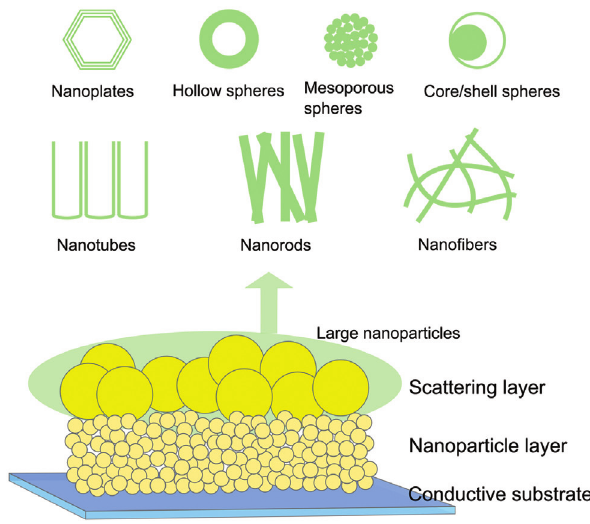
Figure 1 Schematic representation of various scattering com- ponents, such as large TiO NPs, nanoplates, hollow spheres, 2 mesoporous spheres, core/shell spheres, NTs, nanorods and